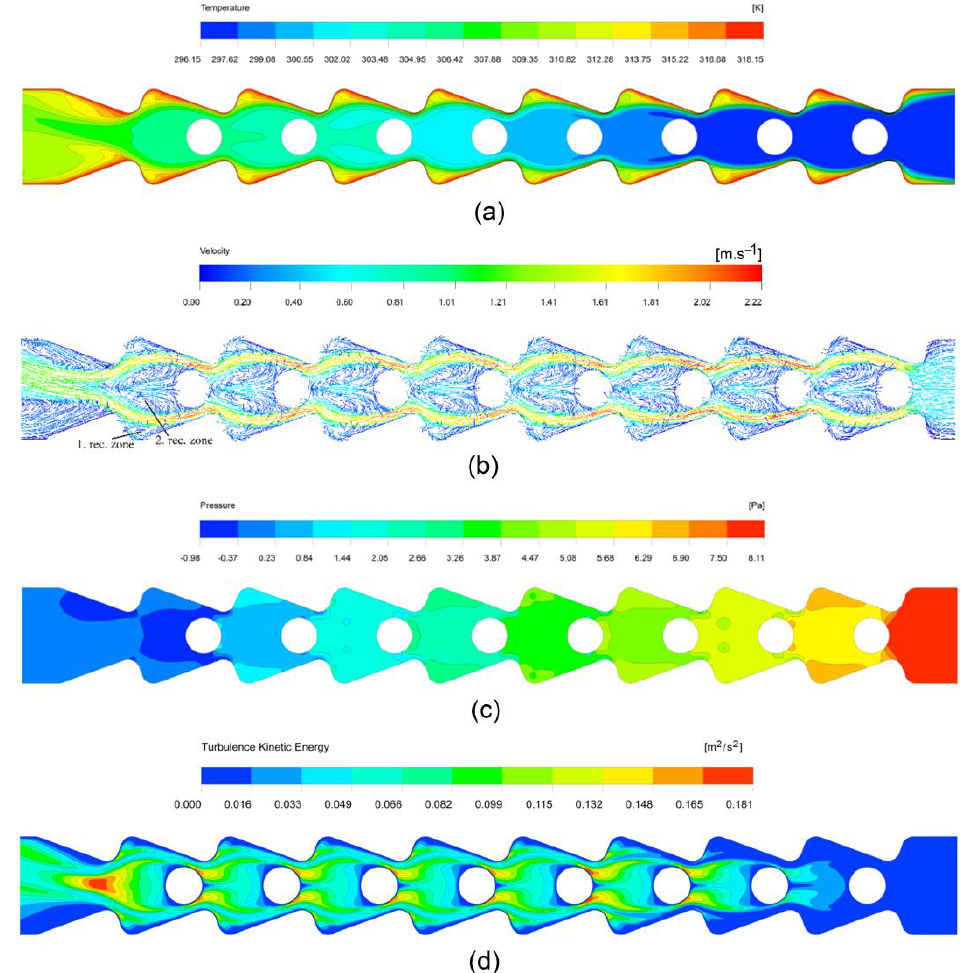
Figure 17. WCCB15 configuration for CVGs position ‘5’ for Re = 1677 ( Q = 10 m3/h), ( a ) temperature field, ( b ) velocity vectors, ( c ) pressure field, ( d ) turbulence kinetic energy.